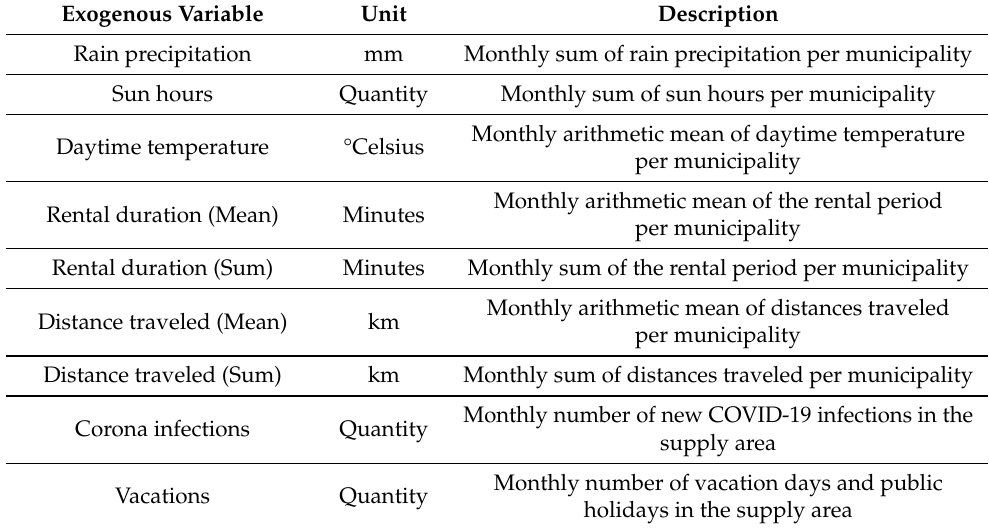
Table 1. Adding exogenous factors can improve model performance. Different exogenous variables from three categories are available: meteorological, system-based and non-system-based